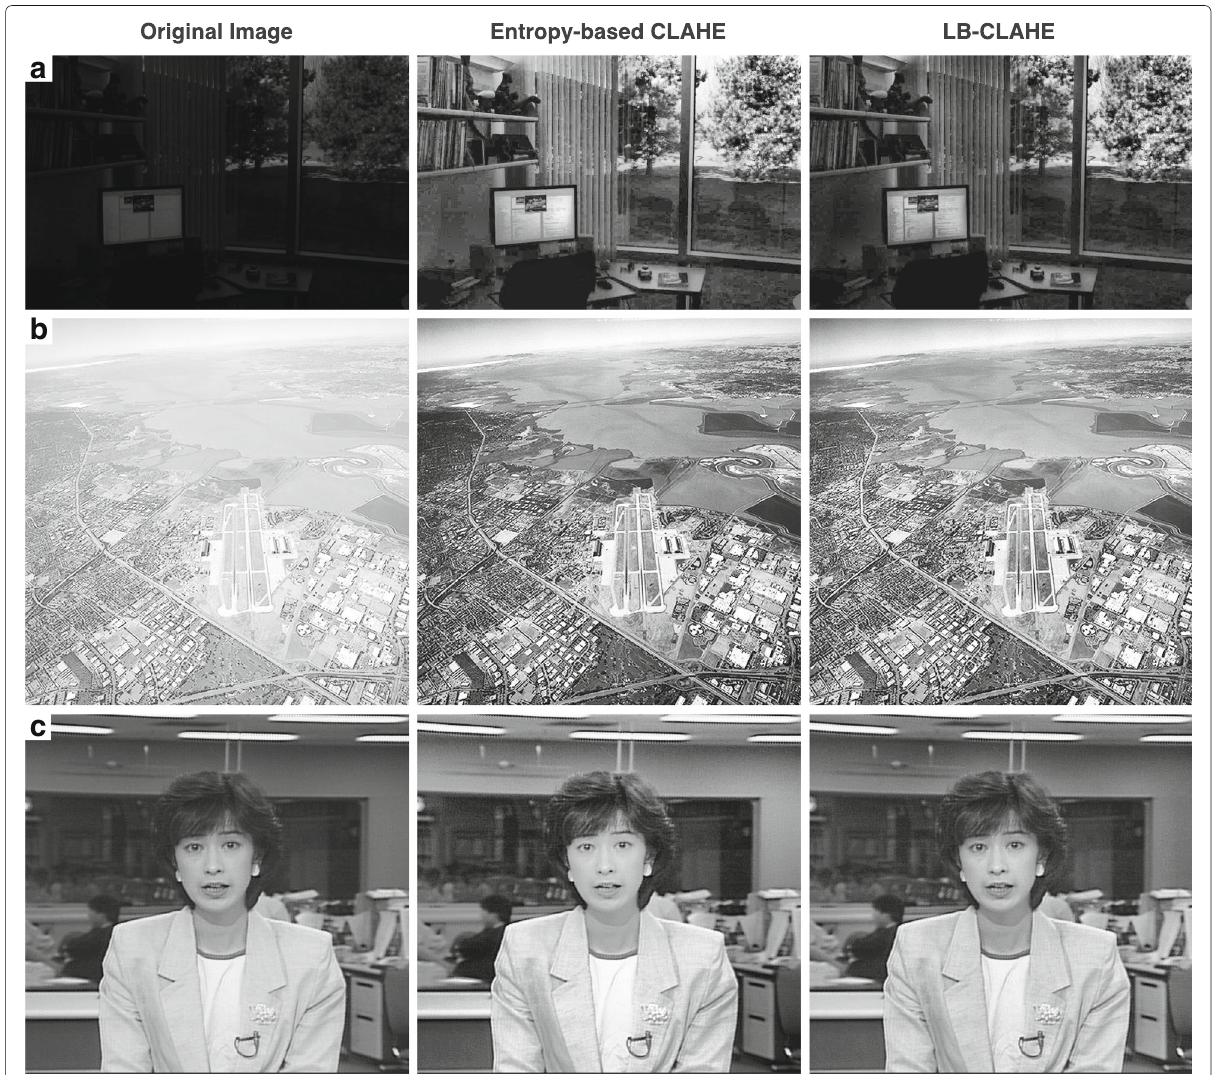
Fig. 11 Visual comparison between the entropy-based method proposed in [26] and LB-CLAHE. Office1 image (a) , aerial image (b) , announce image (c)